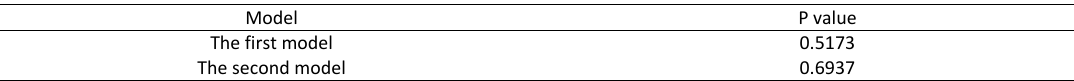
Table 4: The instrumental variables’ p value